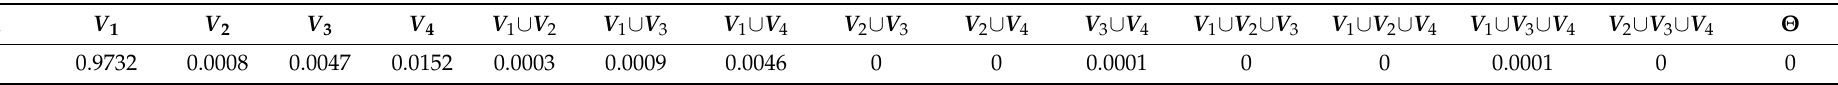
Table 7. The result of second-level fusion for an image of without a crack based on OAR classifiers.